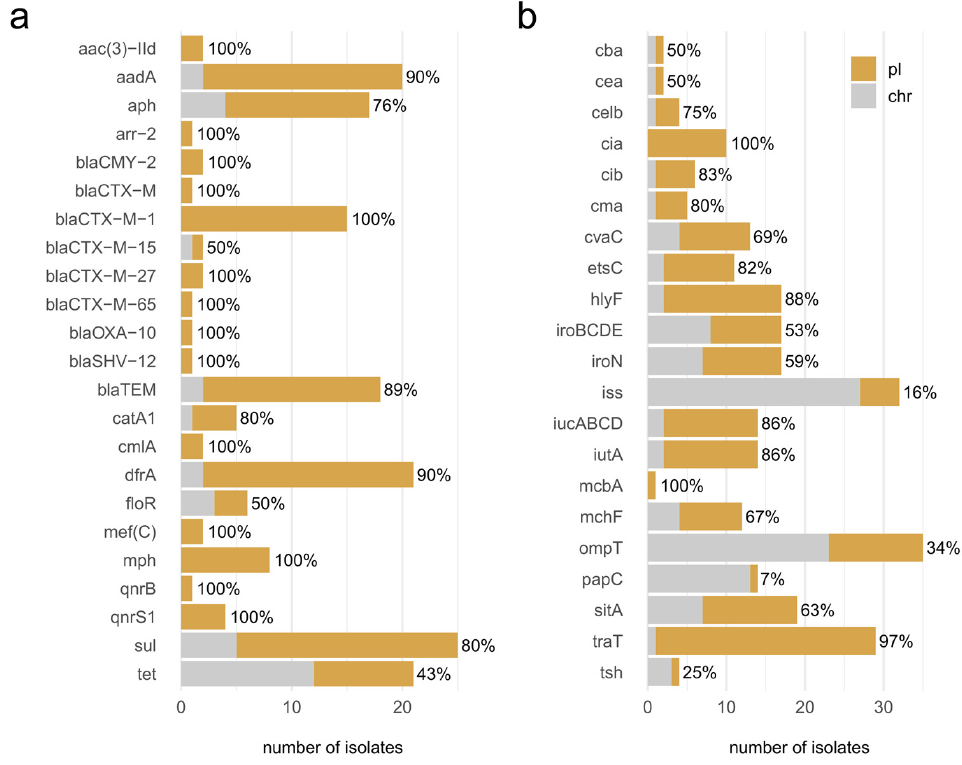
Figure 5. Platon analysis of the plasmid (pl.) or chromosomal (chr.) location of acquired ( a ) AMR genes or ( b ) virulence factors. The contigs encoding genes identified as mediating AMR or as virulence factors were analyzed for plasmid- or chromosome-typical markers in all strains isolated. The percentage value represents the fraction of plasmid-identified contigs for the respective gene.